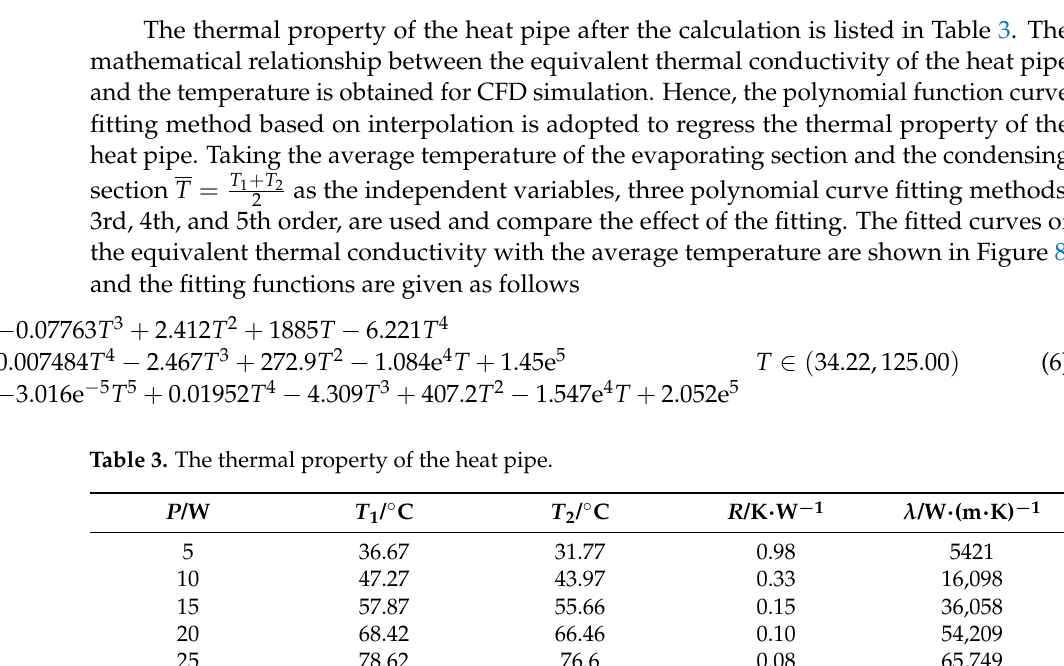
Figure 7. Experimental result of the property test of the heat pipe.